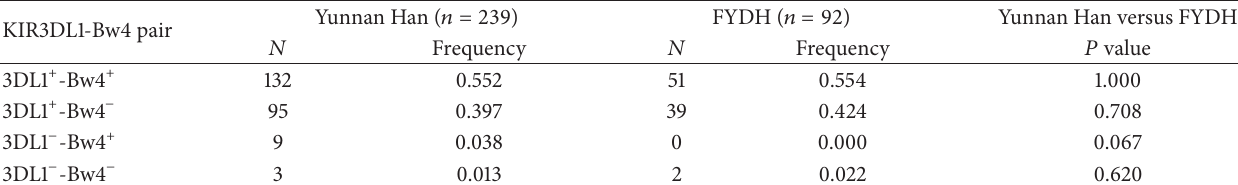
Table 6: Two KIR3D and their ligands HLA-Bw4 in Yunnan Han and